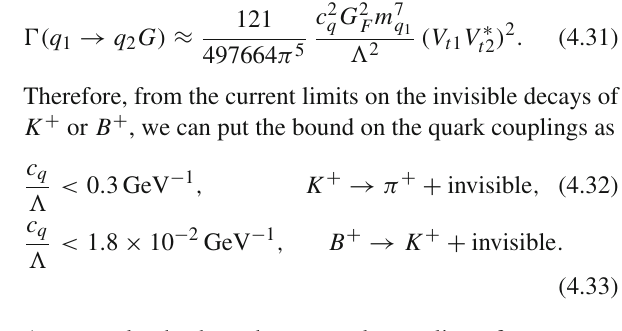
dominance of DM DM → GG channels. But, in this case, the spin-2 mediator produced from the DM annihilation can decay into the SM particles, so the indirect detection exper- iments from cosmic rays such as positrons, anti-protons and gamma-rays can constrain those large mass regions [27,28]. In Fig. 2, XENON1T rules out the non-resonance regions below m DM (cid:9) 200 GeV or 160 GeV for the mediator scale, = 3 , 5 TeV, but leaves the resonance regions with (cid:3)/ c q m G = 2 m DM